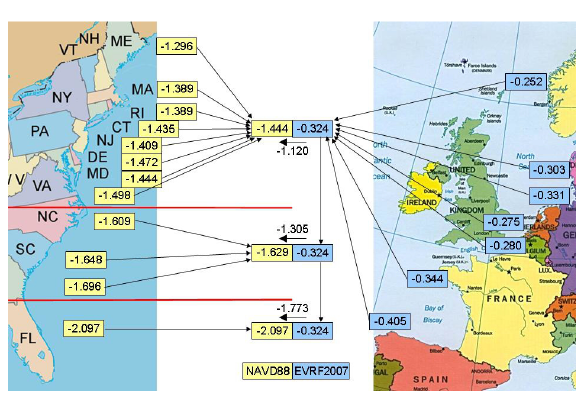
Figure 6. Height system offset estimates between Europe and North America, i.e. between the European Vertical Reference Frame 2007 (EVRF2007) and the North American Vertical Datum 1988 (NAVD88). Omission error from EGM2008 (d/o 181 to 2190) is taken into account for all estimated regional mean